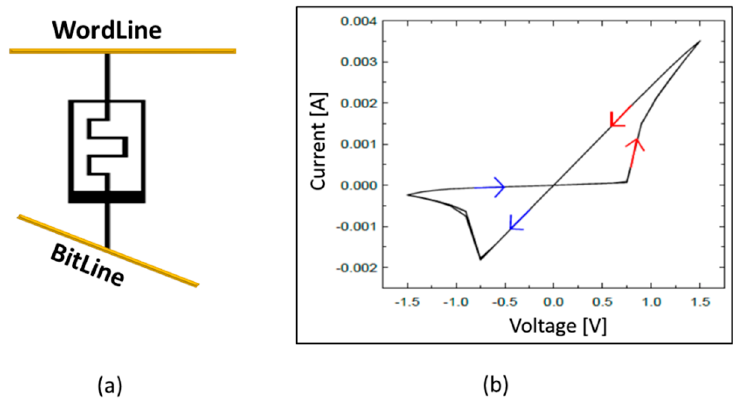
Figure 2. ( a ) Memristor neural network structure; and ( b ) I–V characteristic of memristor device model used in this paper.